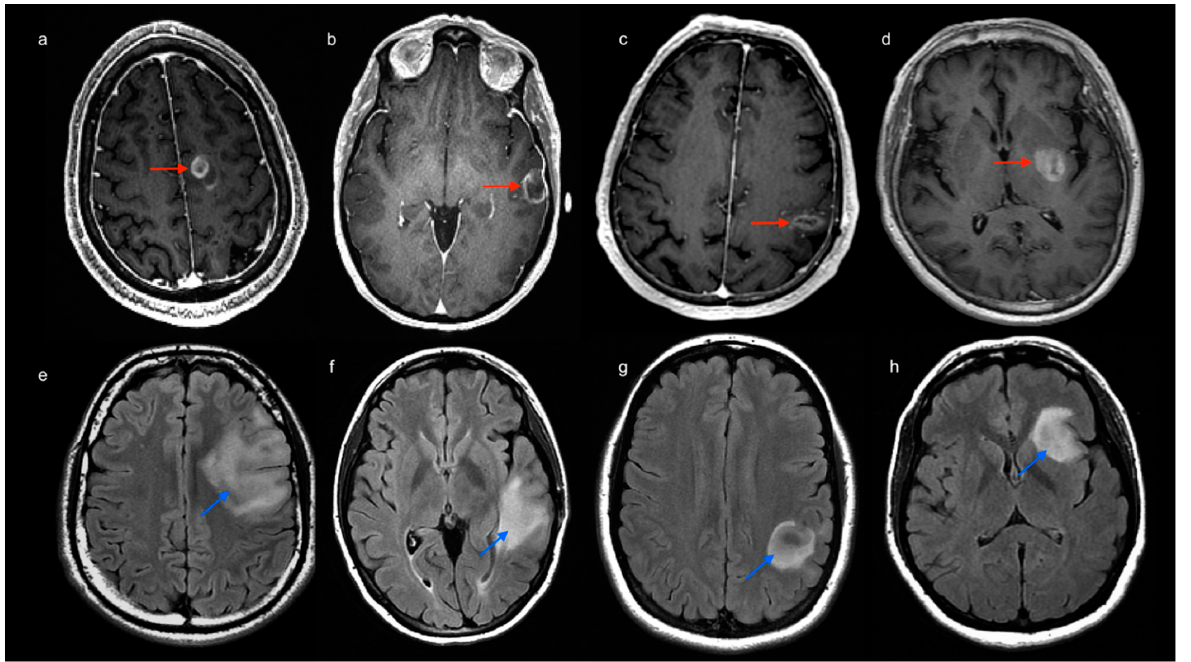
Figure 2. Images above: post-contrast 3D T1-weighted MR scans of four patients with high-grade glioma (image a–d, red arrows). Tumor location was labeled to account for involved lobes as follows: frontal ( a ), temporal ( b ), parietal ( c ) and insular involvement ( d ). Images below: FLAIR-weighted MR scans of four patients with low-grade glioma (image e–h, light blue arrows). Tumor location was labeled to account for involved lobes as follows: frontal ( e ), temporal ( f ), parietal ( g ) and insular involvement ( h ).